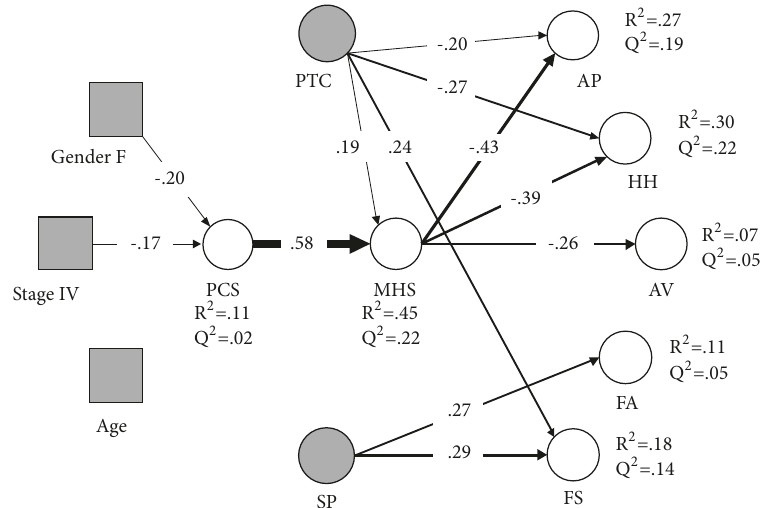
Figure 2: The estimated structural model. Note : all paths were significant at p < .05. Line thickness is proportional to the size of the standardized regression coefficients. Nonsignificant regression paths have been omitted. Legend : Age = patient’s age. Gender F = female versus male gender. Stage IV = Stage IV versus Stage I-III. PCS = Patient’s Physical Functioning. MHS = Patient’s Mental Health. AP = anxious preoccupation. AV = Cognitive Avoidance. FA = Fatalism. FS = Fighting Spirit. HH = Helplessness-Hopelessness. PTC = Positive Thinking Coping Style. SP = Social